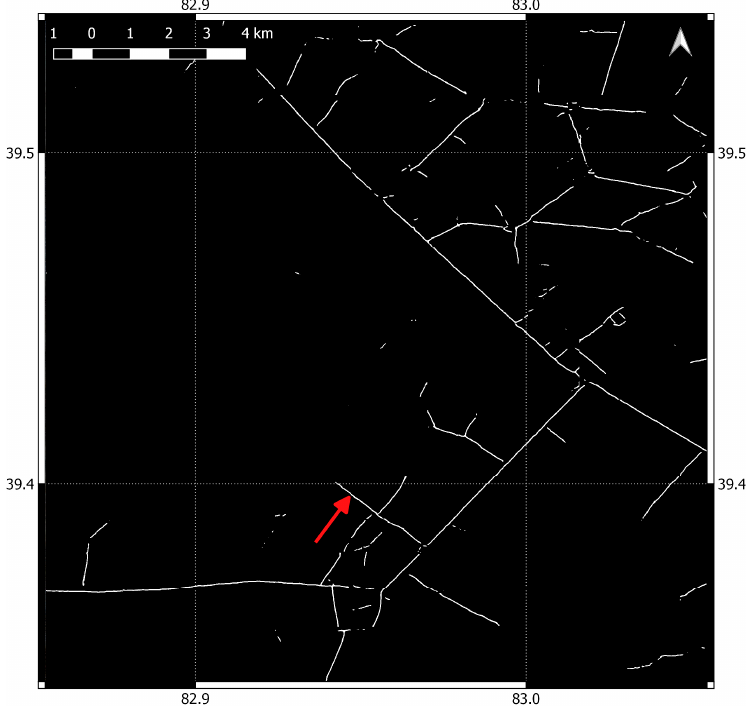
Figure 17. Detected roads for a randomly selected 0.2 × 0.2 degree subset over the Taklimakan Desert AOI. White lines correspond with detected roads. The red arrow points to an example of a formerly buried road segment.